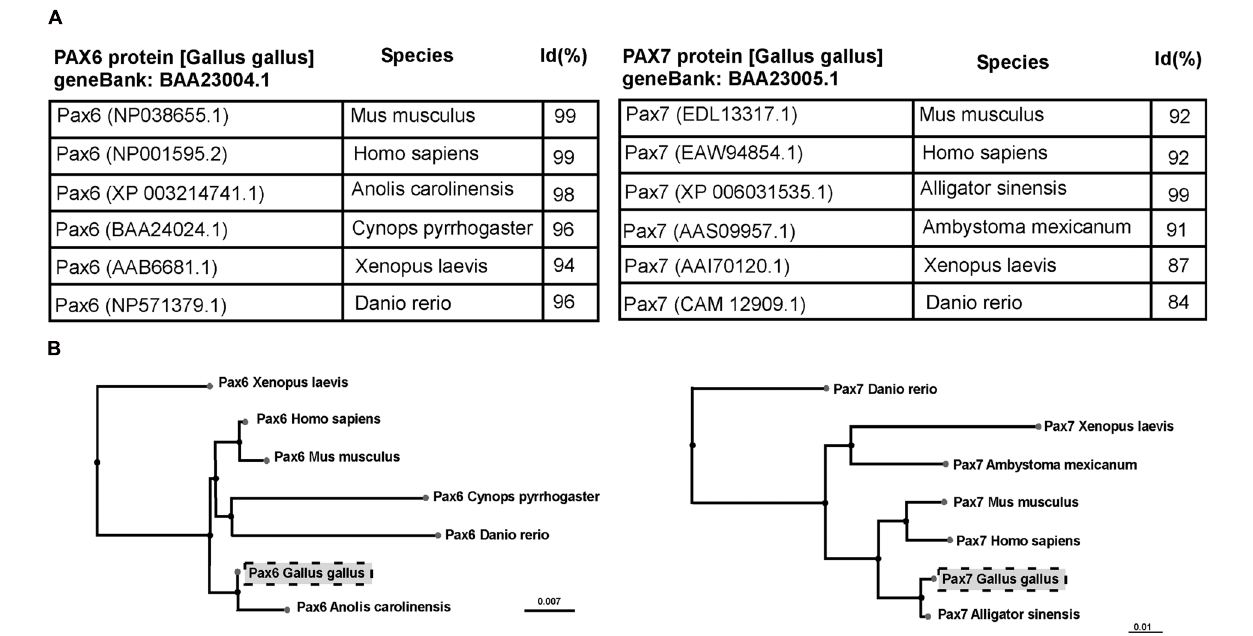
FIGURE 1 |Table (A) and cladogram (B) of the percentage of homologies (Id%) between species, analyzing the sequence of the Pax6 and Pax7 genes. Sequences were identified following BLAST (Basic Local Alignment Search Tool) that computes a pairwise alignment